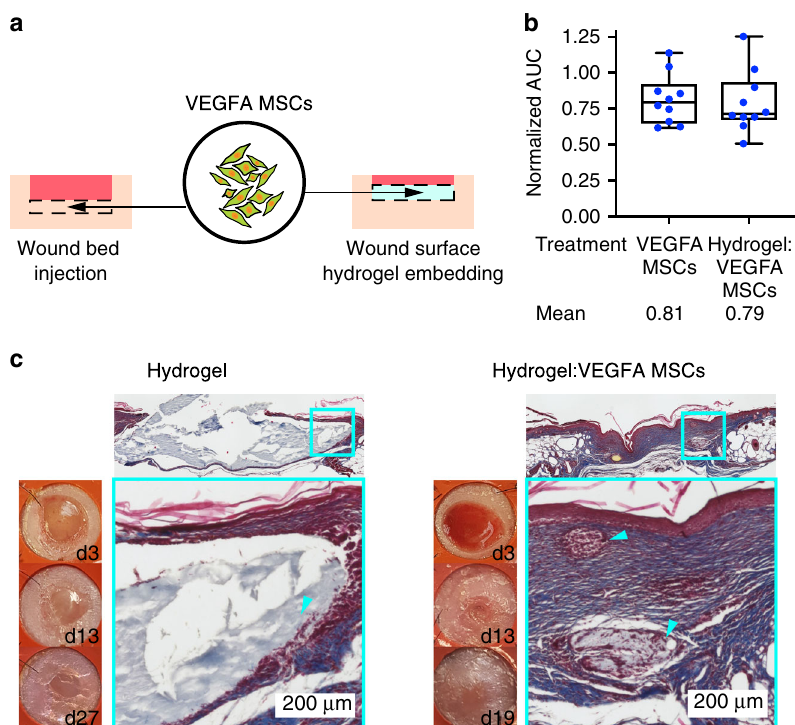
Fig. 6 Engineered hMSCs are compatible with hydrogel scaffold treatment for wound healing. a VEGFA MSCs were delivered by injection in the wound bed or by HyStem ® -HP hydrogel embedding on top of the wound bed on the day of wounding. b Box and whiskers plot shows AUC of individual wounds, which were normalized against mean AUCs of PBS controls (biological replicates: n = 10 per treatment group). Minima and maxima are bounded by whiskers, lower bounds, centers, and upper bound of boxes represent the 25th, 50th, and 75th percentiles, respectively. Mean AUCs of all treatment and control groups were different according to ordinary one-way ANOVA test ( p < 0.0001). Plotted treatment groups have no signi fi cant differences in AUCs. c Wound images show appearances of wounds treated with HyStem ® -HP hydrogel alone (label: “ Hydrogel ” ) and embedded VEGFA MSCs (label: “ Hydrogel:VEGFA MSCs ” ) over the course of observation period. Masson ’ s trichrome stained cross-section images show structure of granulation tissues at the end of observation period. Cyan boxes indicate location of high-resolution images. Cyan arrowheads indicate residual Hystem ® -HP hydrogel. Source data are available in the Source data fi